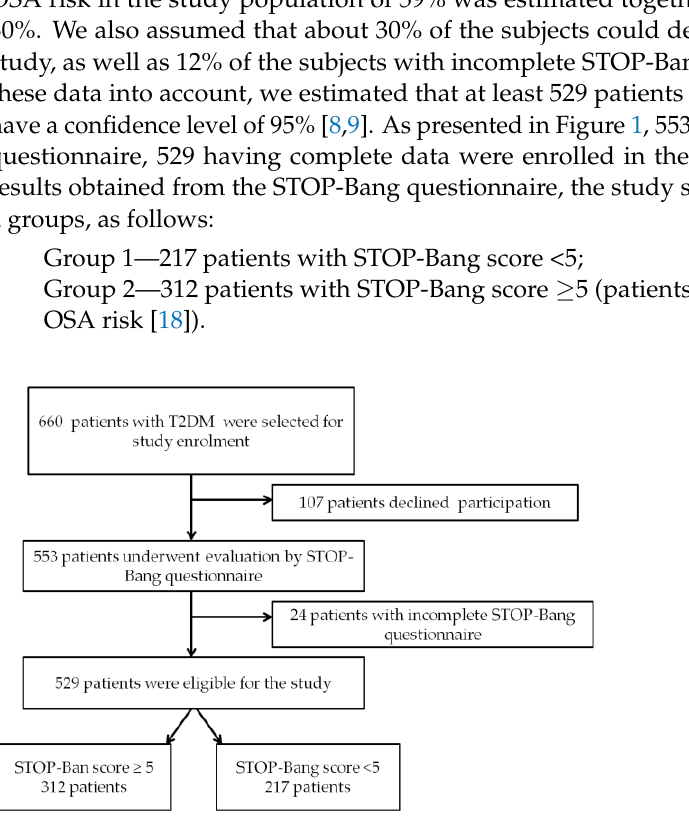
Figure 1. Study flow chart. T2DM: type 2 diabetes mellitus; OSA: obstructive sleep apnea.